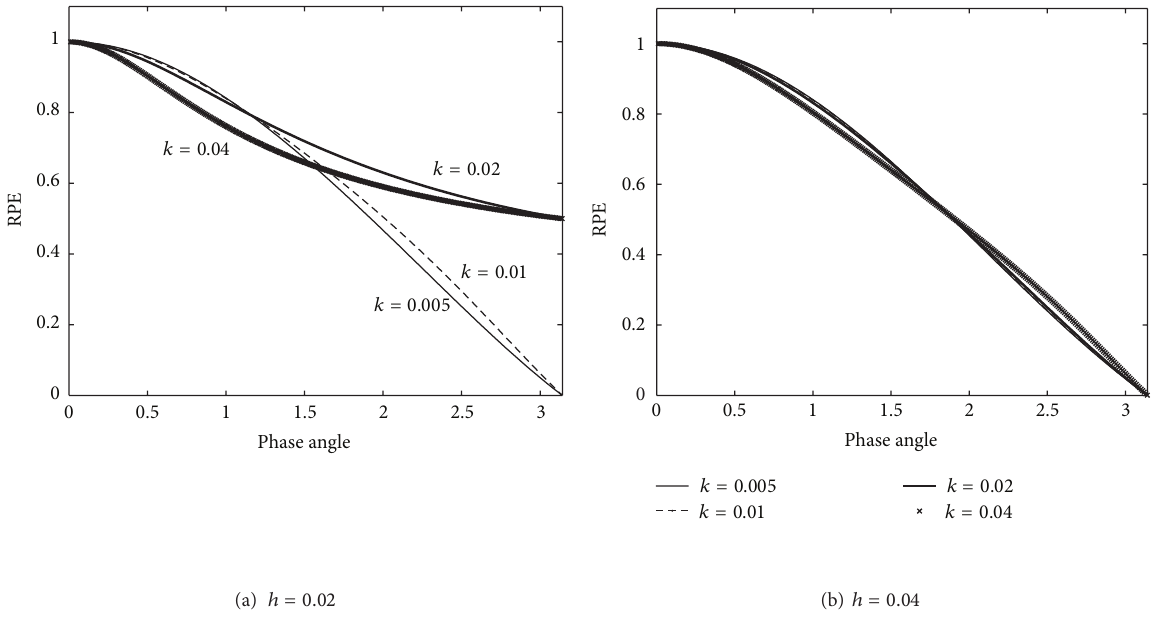
Figure 4: Plot of RPE versus phase angle for the Crank-Nicolson scheme.